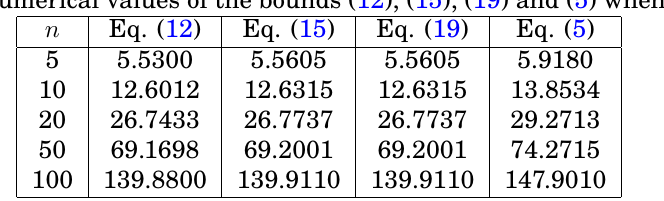
n − 2 (cid:122) (cid:125)(cid:124) (cid:123) , n , 1 , . . . , 1 ) 2 2